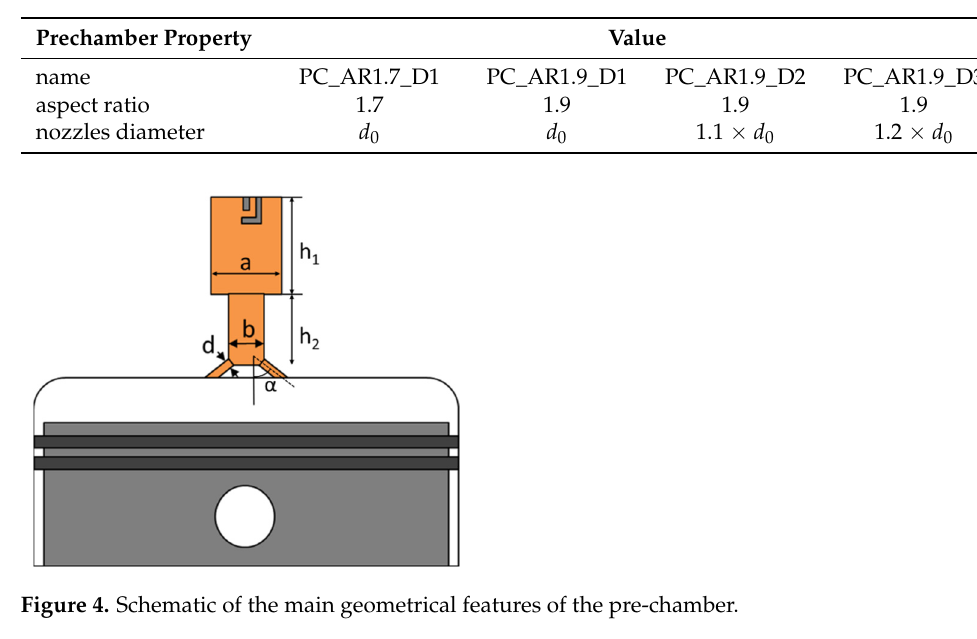
Table 4. Geometrical configurations of simulated pre-chambers.